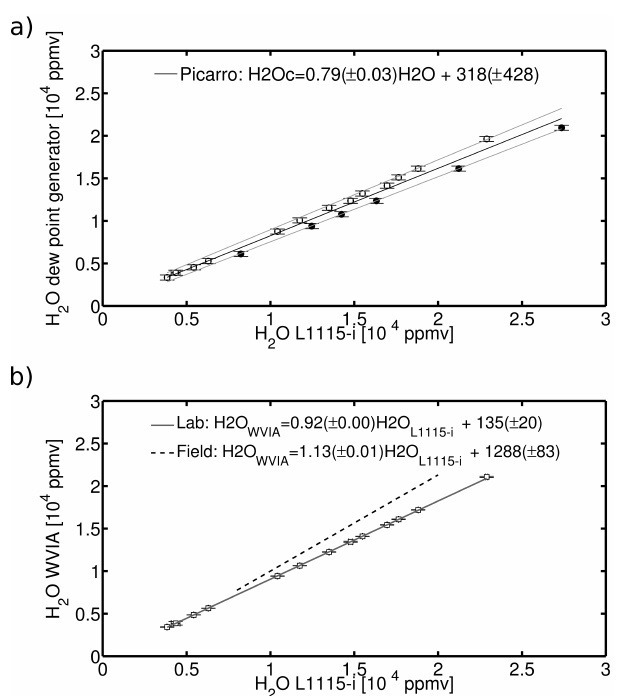
Fig. 4. Calibration of water vapour mixing ratio measurements. (a) L1115-i laboratory calibration measurements. The calibration experiment with the dew point generator was done twice: once with L1115-i connected to the LI-610 alone (full circles) and once with L1115-i and WVIA connected in parallel to the LI-610 (open squares). A least squares fit to all data points of the two experi- ments is shown by the black line. The grey lines show the standard deviation of the least square fit. In (b) WVIA and L1115-i measure- ments are compared using parallel laboratory measurements (grey line) and parallel field measurements (black dashed line). The lab- oratory data points (black squares) show average measured water concentration of hourly runs and their standard deviation. The grey line represents a least square fit to the laboratory data points. The black dashed line represents the least square fit to the ambient air measurements. The uncertainty of these fits is very small and thus not